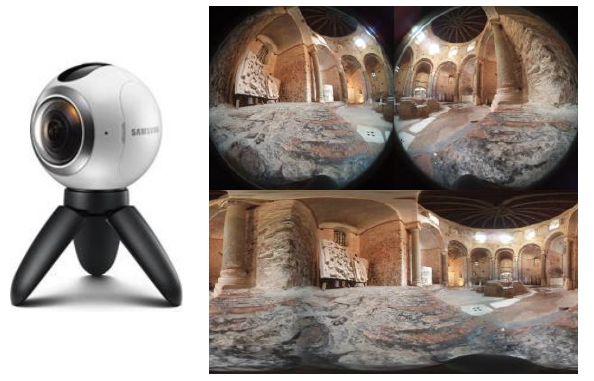
Fig. 1. The Samsung Gear 360 and its two circular images (top) turned into a single equirectangular projection